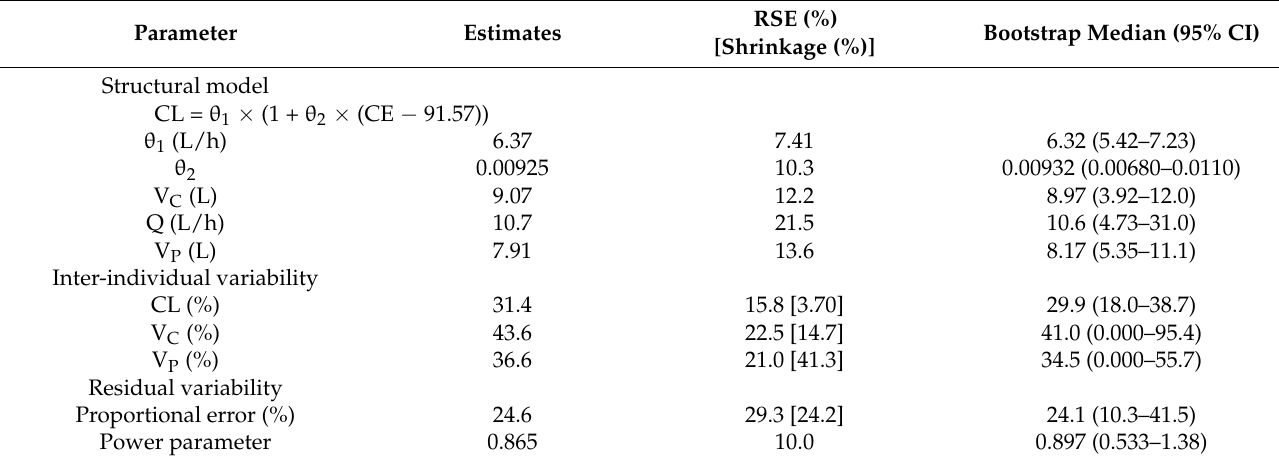
Table 2. Population PK parameter estimates for meropenem.